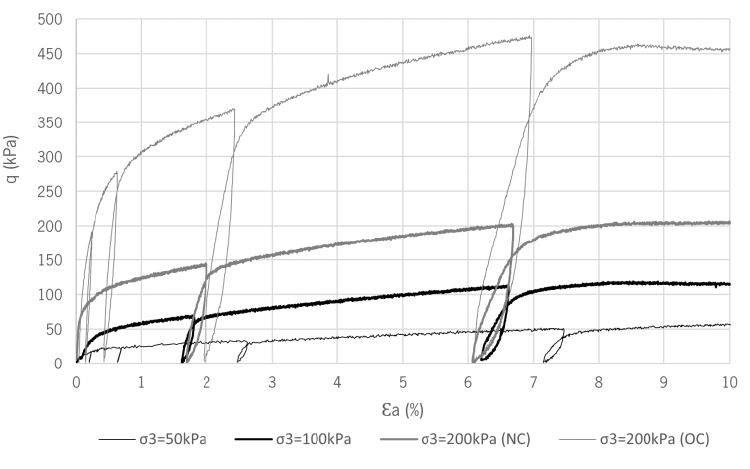
Figure 12. Evolution of the deviatoric stress with the axial strain.